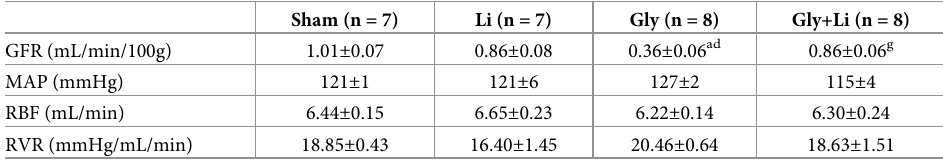
Table 1. Renal function and hemodynamic parameters evaluated after the 24h